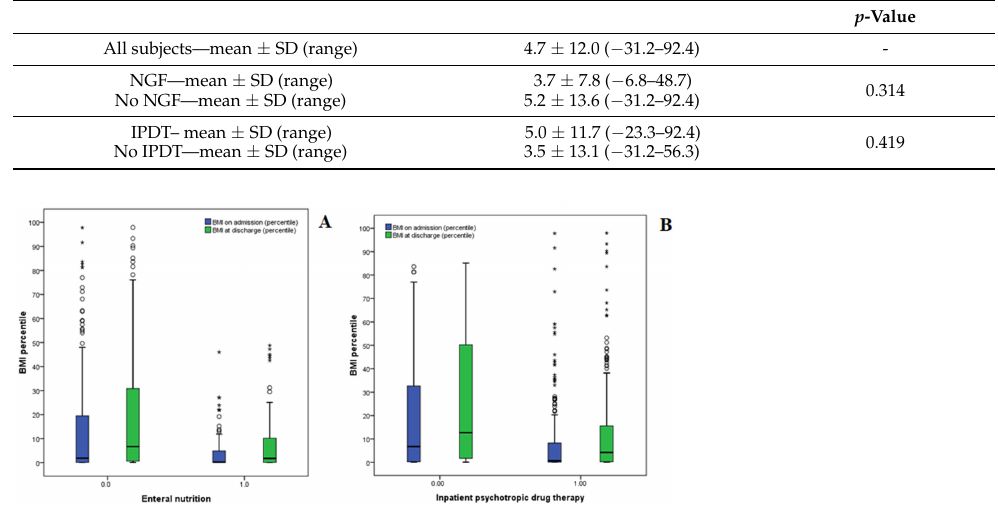
Figure 2. Effects of NGF ( A ) and IPDT ( B ) on BMI percentile increases. Hollow circles are outliers (more than 1.5 × IQR from the first and third quartile) and asterisks are extreme values (more than 3.0 × IQR from the first and third